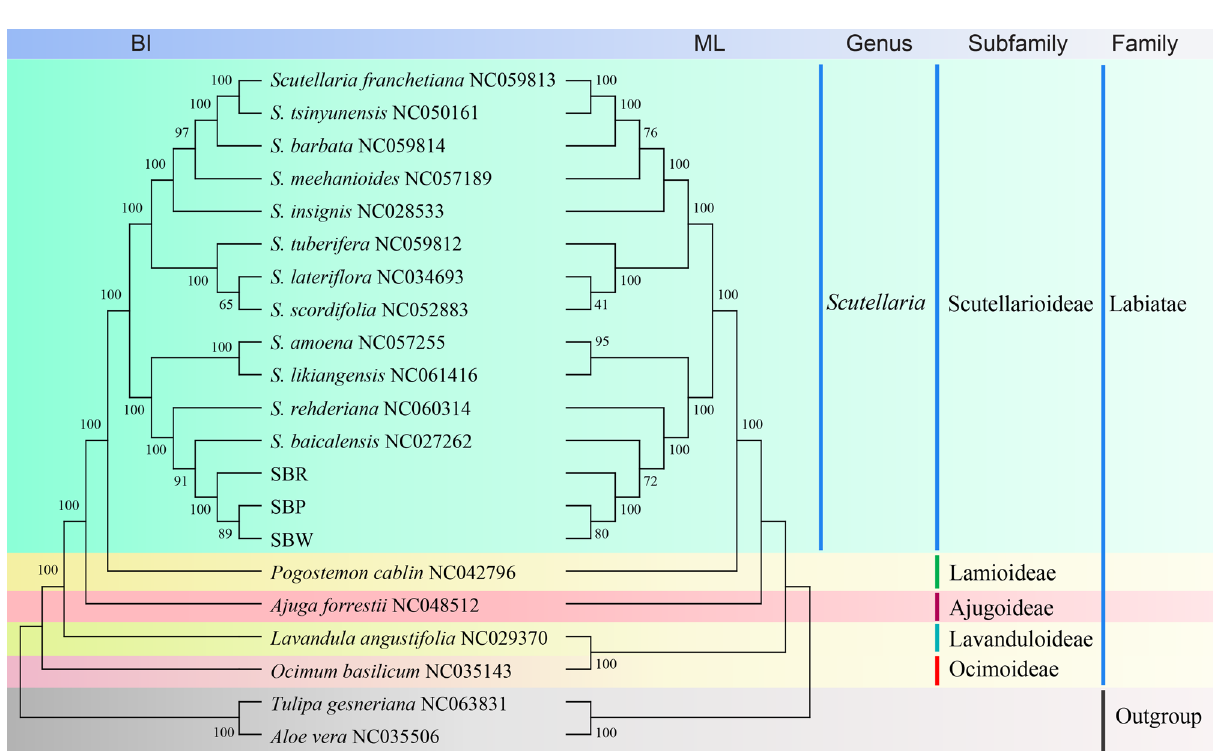
Figure 8. Sequencing chromatograms of the barcode regions from SBW1, SBW2, SBR1, SBR2, SBP1 and SBP2, with consensus sequence and alignment.